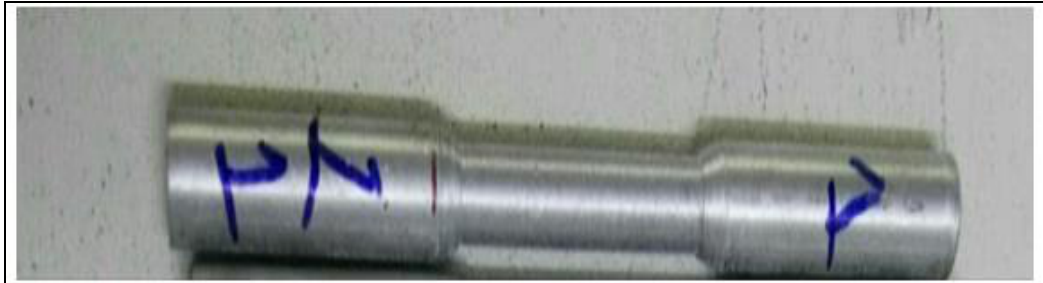
Figure 1: Sample of Tensile